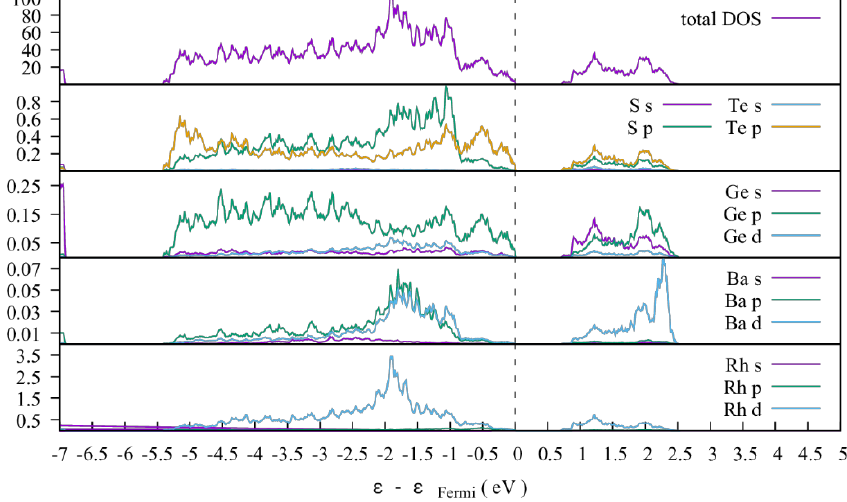
Figure 8. Total and atomic orbital-projected density of states (DOS) of BaRh 2 Ge 4 S 4 Te 2 . The projected DOS are scaled by the number of corresponding atoms.